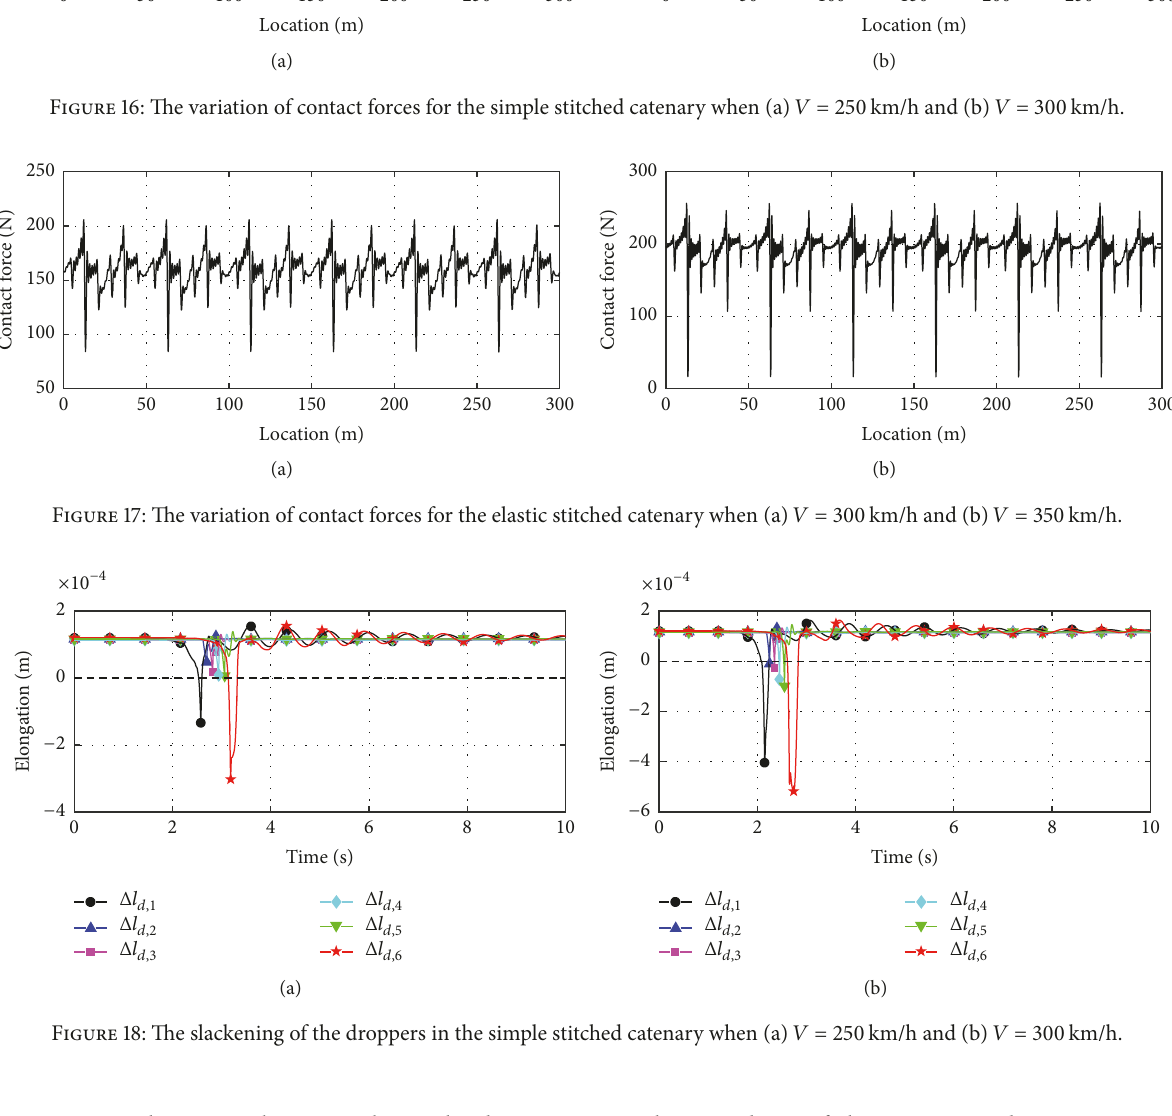
contact wire are the core tasks in simulating the dynamic behavior of the pantograph-catenary system. A